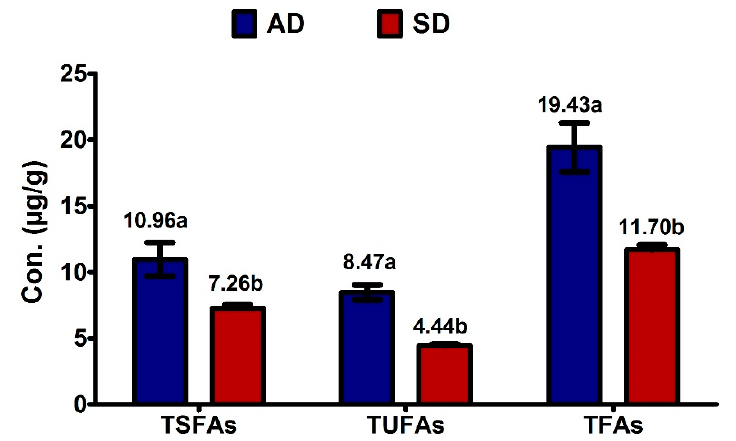
Figure 1. Effect of drying method on total saturated fatty acids (TSFAs), total unsaturated fatty acids (TUSFAs) and total fatty acids (TFAs) of raisins. Different lettering indicates a significance level p < 0.005; n = 3.